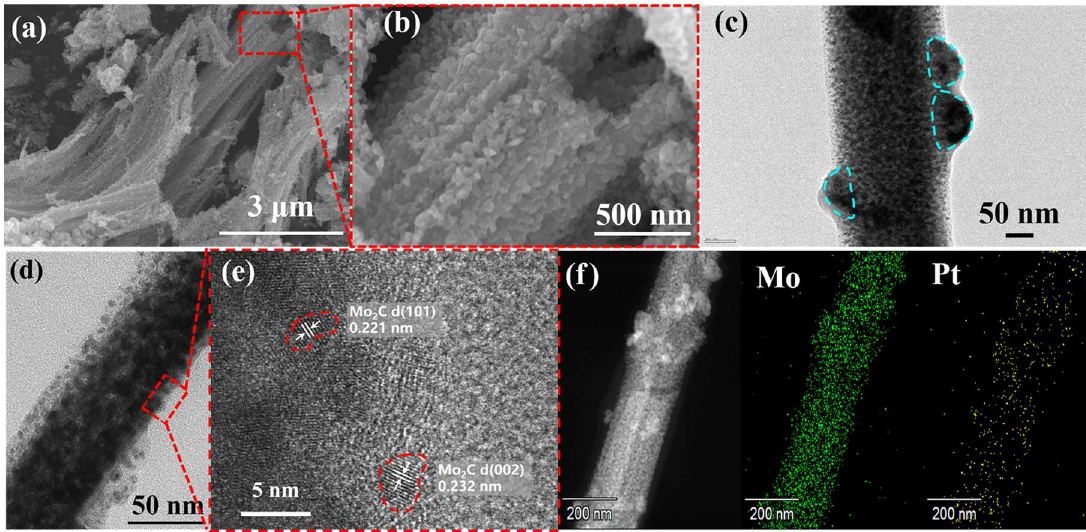
Figure 4. ( a ) and ( b ) SEM, ( c ) TEM, ( d ) TEM and ( e ) HR-TEM of 2% Pt-Mo 2 C catalyst, and ( f ) the STEM image and the corresponding elemental mapping.